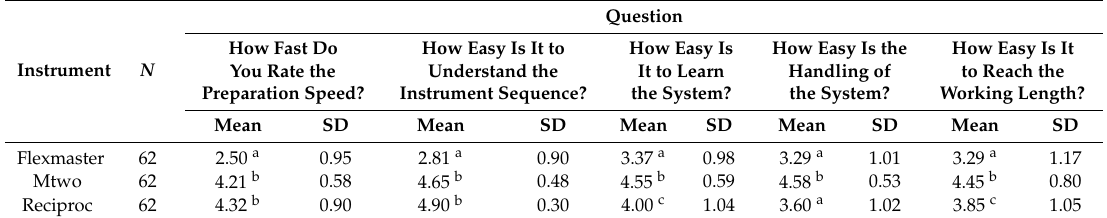
Table 2. Mean values of students’ subjective questionnaire evaluation of the three root canal preparations strategies (rank 1 = very slow/very difficult to rank 5 = very fast/very easy).